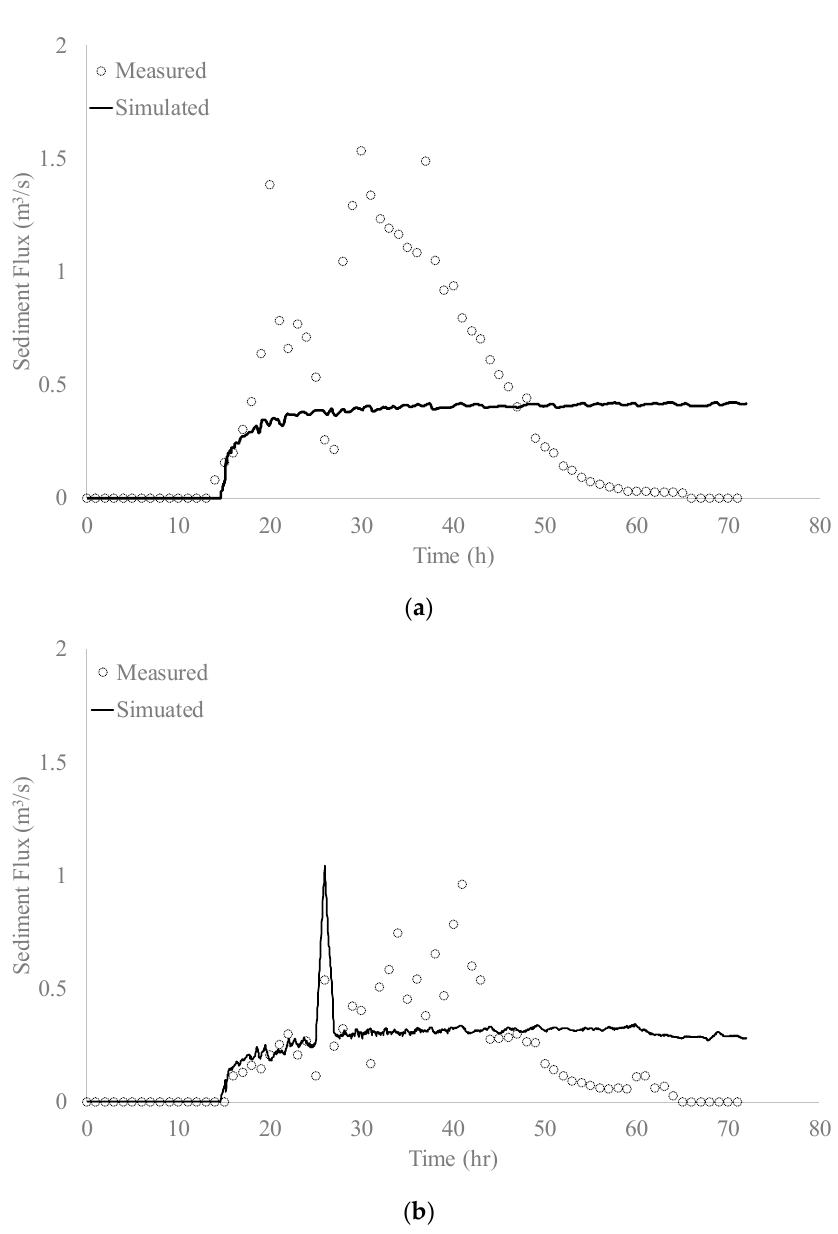
Figure 9. Released sediment through ( a ) PRO and ( b ) PPI during Typhoon Soudelor.